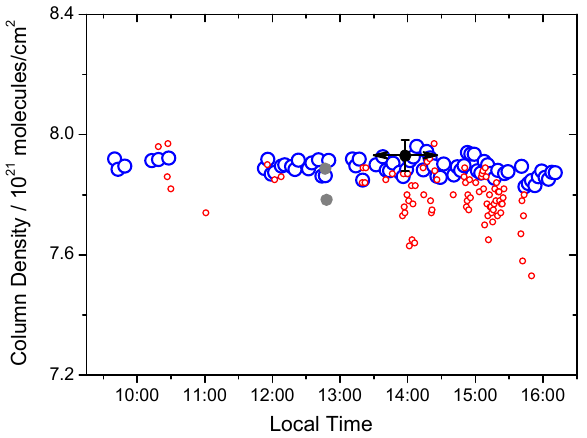
Fig. 6 Fig. 6. Time series of CO 2 column densities measured on 26 Au- gust 2009 by OSA, FTS, balloon and GOSAT. OSA: large open cir- cles; FTS: small open circles; Balloon: arrows; GOSAT: gray solid